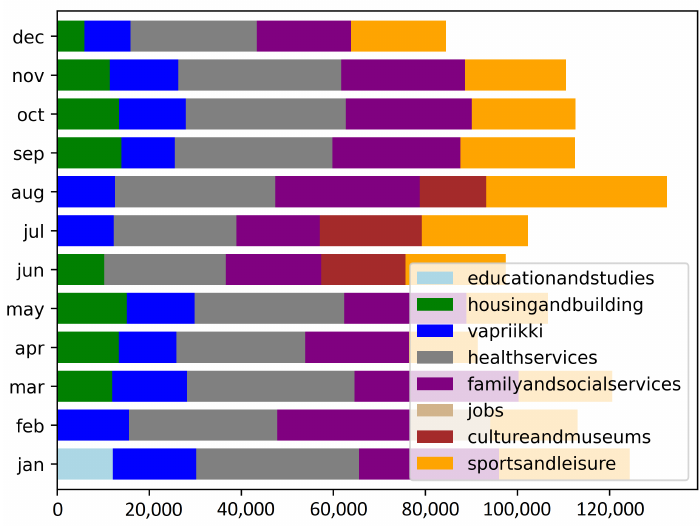
Figure 2. Annual monthly top-5 topic